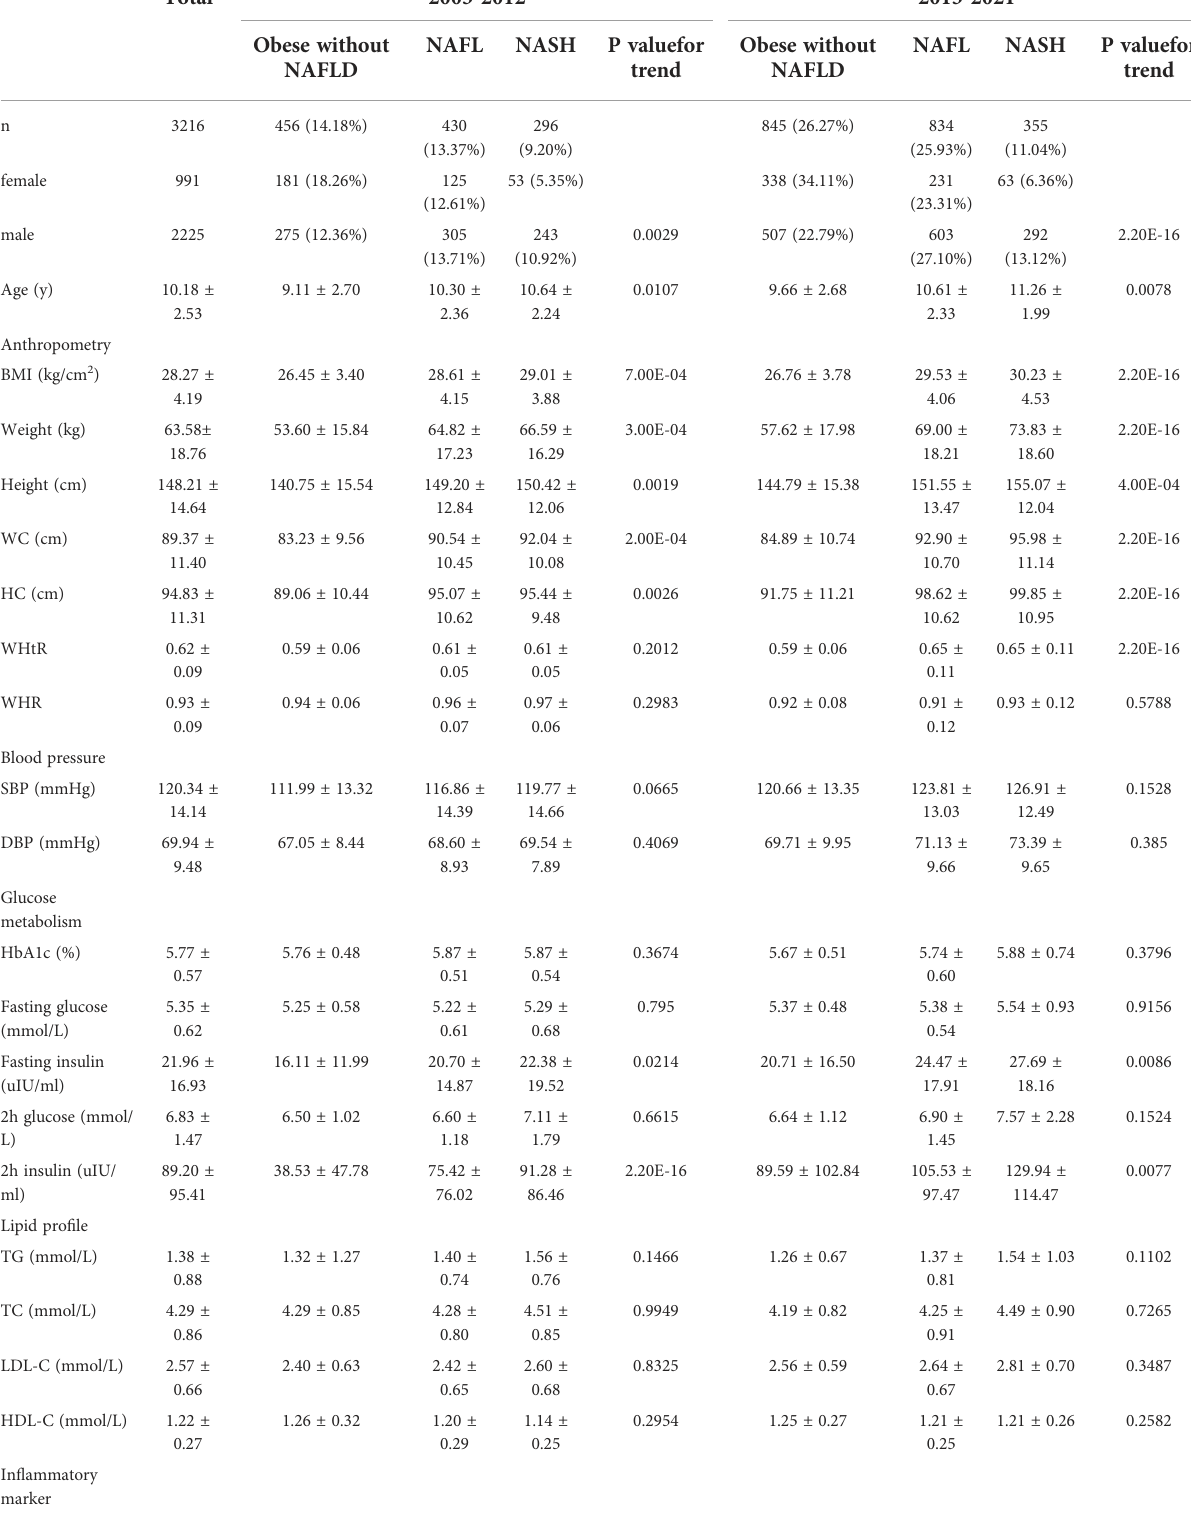
TABLE 1 Clinical features of the participants over the recent 19